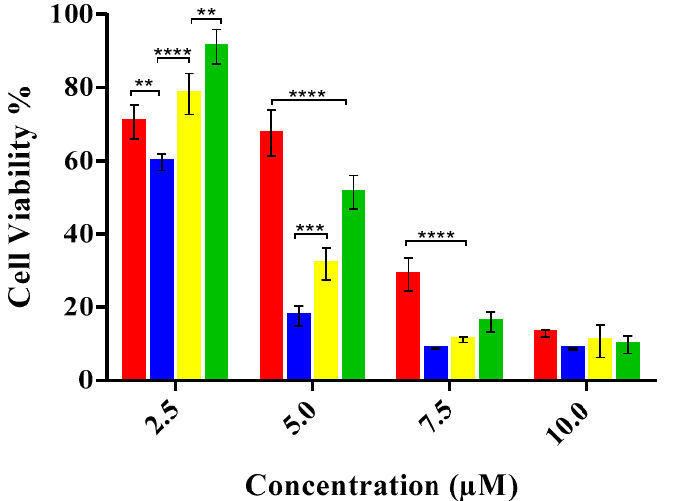
Figure 3. Cell cytotoxicity of the free 8-QO-Pt compound and 8-QO-Pt-loaded (+) formulations of NLC/RFV against the HT-29 cell line for 24 h. Data are shown as mean ± SD ( n = 3). (** p < 0.001; *** p < 0.0003; **** p < 0.0001). Table 3. IC 50 values (µM) of free 8-QO-Pt and the formulations after 24 h of incubation.